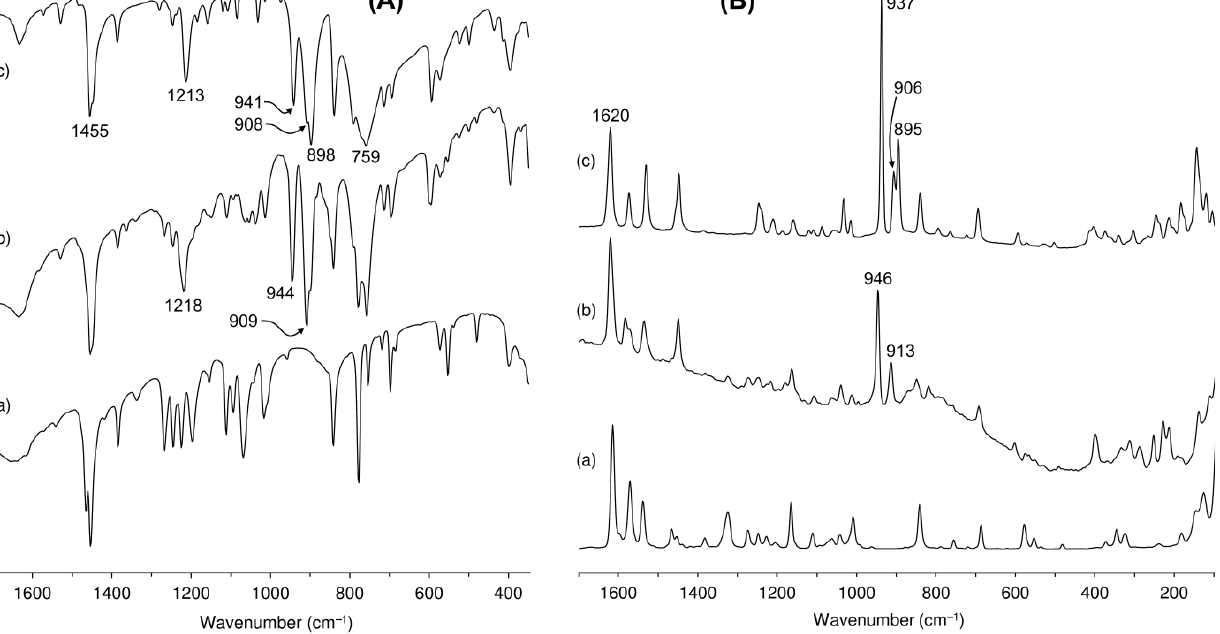
Figure 4. FT-IR spectra in the range of 350 – 1700 cm −1 ( A ) and Raman spectra in the range of 100 – 1700 cm −1 ( B ) of (a) ligand Hpto, (b) complex 1 , and (c) compound 2 . A 1 H- 13 C HSQC NMR experiment was performed for the free ligand Hpto to allow for the unambiguous assignment of the respective 1D spectra (Figure S1). The solid-state 13 C{ 1 H} CP MAS NMR spectrum of Hpto was interpreted in accordance with the assignments made for the solution spectrum, with three distinct peaks being observed for the tetrazole carbon atom (Ctz) and the pyridyl carbon atoms directly bond to nitrogen (C2 and C6), while the resonances for the remaining three pyridyl carbons (C3, C4, and C5) overlapped to give one intense peak centered at 127.9 ppm, with a shoulder at 127.0 ppm (Figure 5). The solid-state 13 C{ 1 H} CP MAS NMR spectrum of complex 1 is consistent with the bidentate coordination of Hpto to the Mo VI center since the resonance for Ctz is shifted strongly downfield by 6.3 ppm relative to that for the free ligand. The remaining pyridyl carbon signals are tentatively assigned on the basis that the resonances for C3, C5, and C6 undergo minor downfield shifts of less than 1.3 ppm relative to those for Hpto, while the resonances for C2 and C4 are downfield-shifted by about 4 and 9 ppm, respectively. Two sharp resonances are observed at 26.5 and 69.4 ppm for the THF molecules of crystalliza- tion.